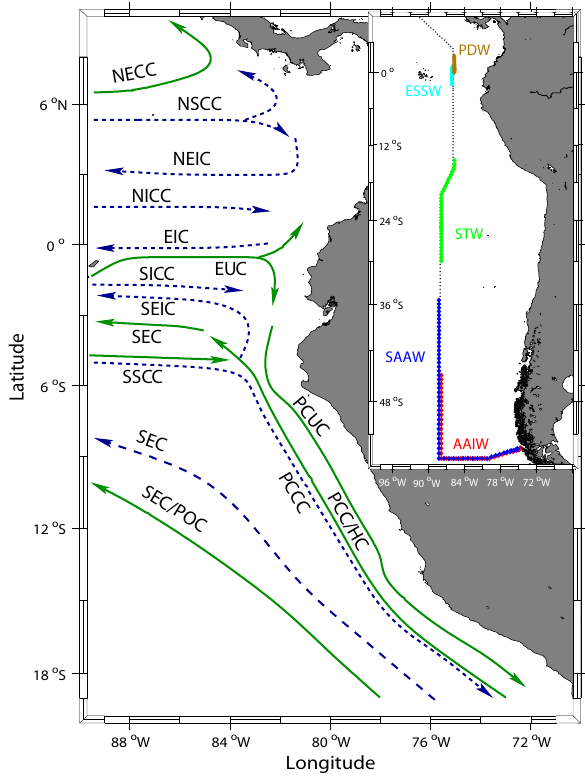
The two occupations of the 85 ◦ 50 0 W transect represent contrasting ENSO phases. The 1993 cruise was